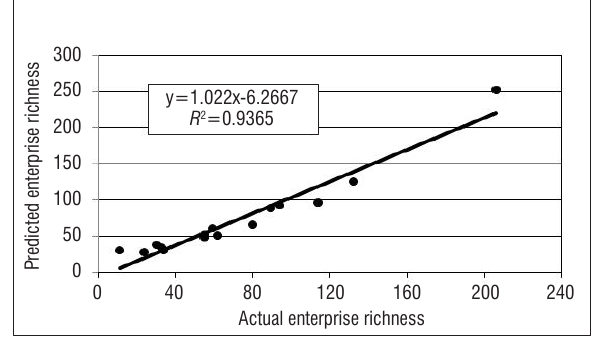
Figure 6: Enterprise richness in Gouritz Cluster Biosphere Reserve towns predicted by the 1946/1947 power law versus actual enterprise richness measurements for